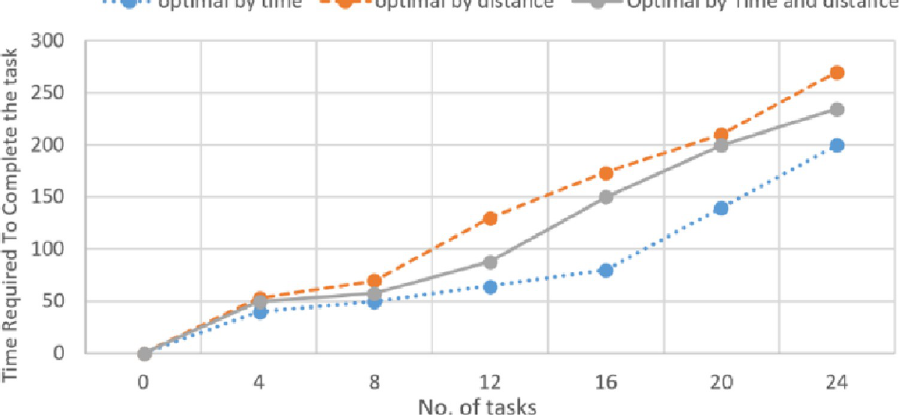
Fig 10. Time required for task completion with different